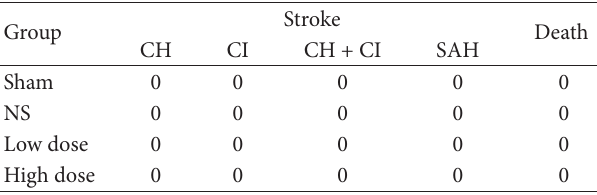
Figure 1: Effect of scutellarin treatment on systolic blood pres- sure (SBP). Baseline systolic blood pressure (SBP) (mmHg) was similar among the four experimental groups. SBP was significantly increased in hypertensive groups compared with the sham-operated group. No significant difference in SBP was found in NS rats prior to treatment. However, SBP was significantly reduced with low- and high-dose scutellarin. ∗ 𝑃 < 0.001 versus sham group; # 𝑃 > 0.05 , 󳵳 𝑃 < 0.001 versus NS group; Q 𝑃 < 0.001 , versus before treatment; 󳶃 𝑃 > 0.05 , & 𝑃 < 0.001 versus low-dose group. Table 1: Occurrence of stroke and death in different groups of rats. There were no incidences of stroke or death in the four